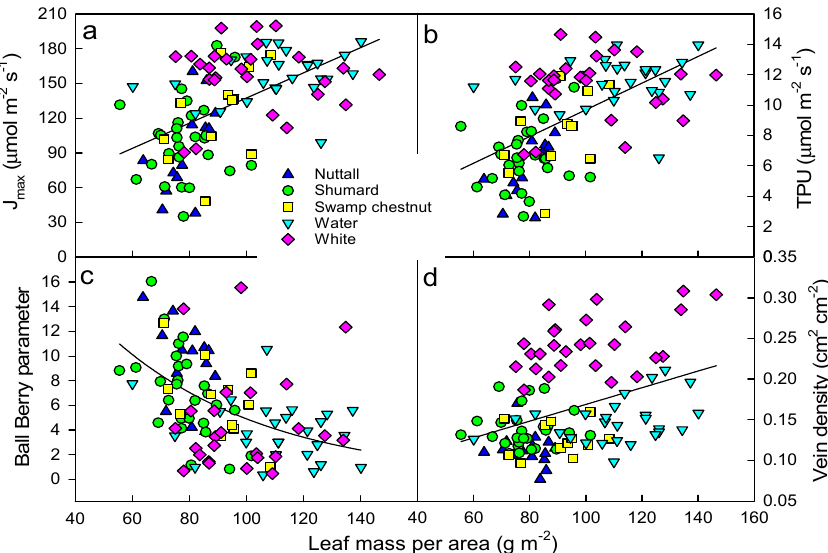
Figure 3. Relationships between leaf mass per unit area (LMA; g m − 2 ) and ( a ) electron transport limited carboxylation rate (J max ; μ mol m − 2 s − 1 ; r 2 = 0.28; p < 0.0001), ( b ) triose phosphate utilization limited carboxylation rate (TPU; µ mol m − 2 s − 1 ; r 2 = 0.32; p < 0.0001), ( c ) the Ball–Berry parameter (unitless; r 2 = 0.21; p < 0.0001) and ( d ) leaf vein density (cm 2 cm -2 ; r 2 = 0.14; p < 0.0001) for Nuttall (dark blue, up triangle), Shumard (green circle), swamp chestnut (yellow square), water (light blue down triangle), and white oak (magenta